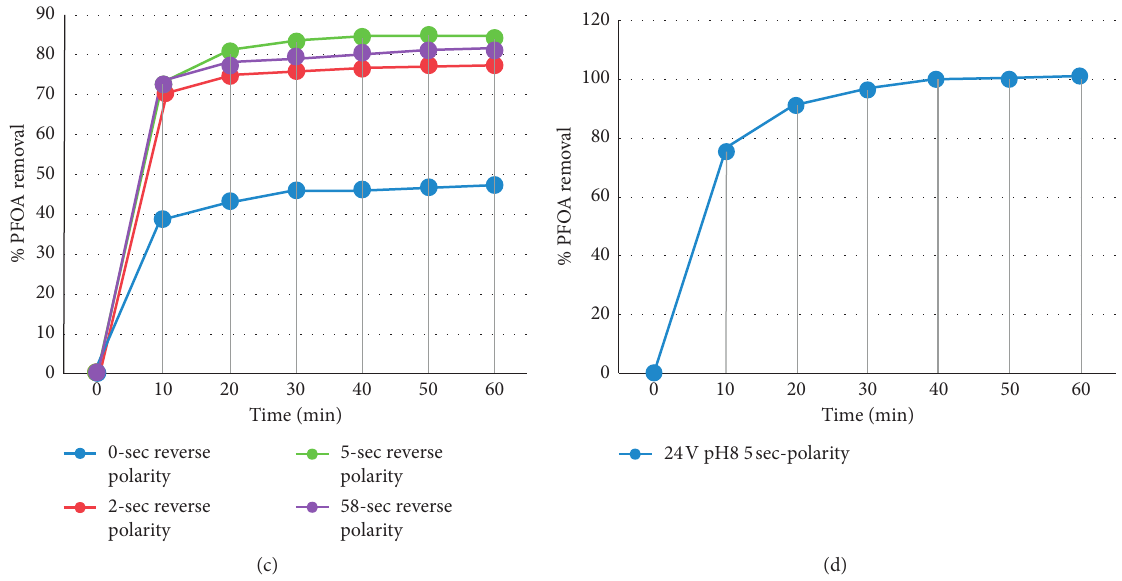
Figure 4: PFOA removal efficiency based on (a) voltage capacity, (b) pH, (c) polarity, and (d) combined factors. Table 2: Measured concentration ( μ g/L) of microcystins in Grand St. Mary’s source of drinking water (Celina, Ohio) in 2017. Measurement day Spring